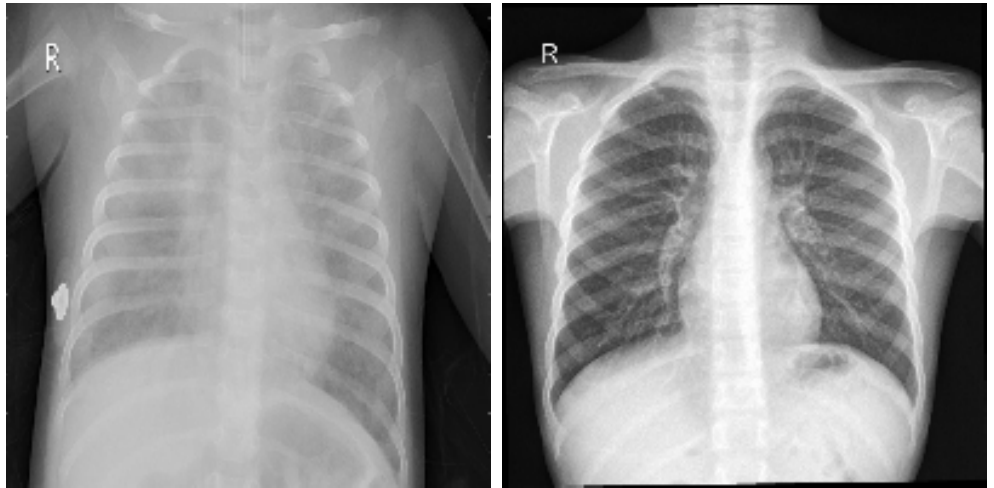
Figure 9. Examples of radiography images of patients not infected with COVID-19 (negative